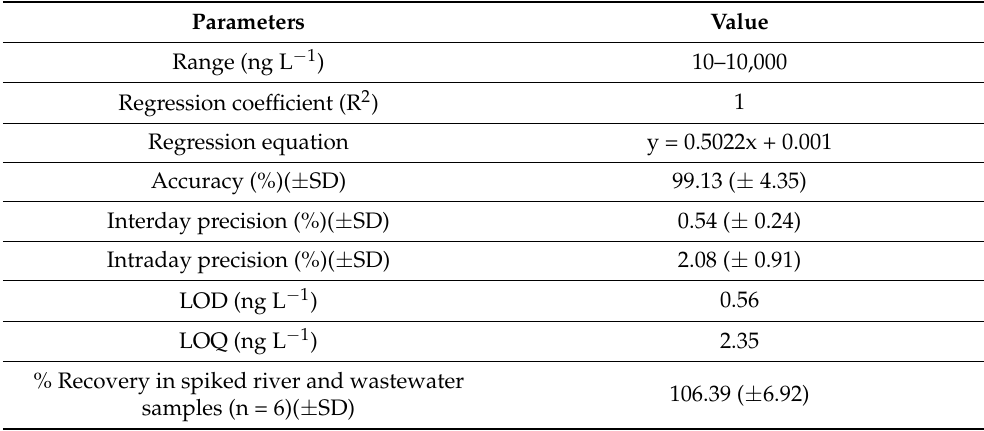
Table 4. Validation parameters of the ICP-MS method.